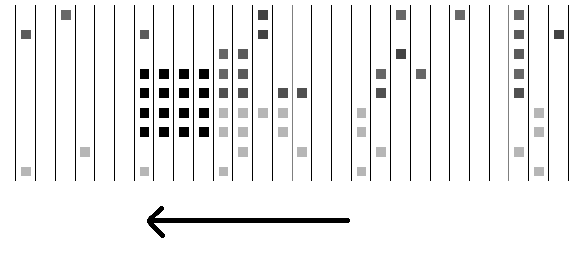
Fig. 4. Modelling driving around a wide obstacle.